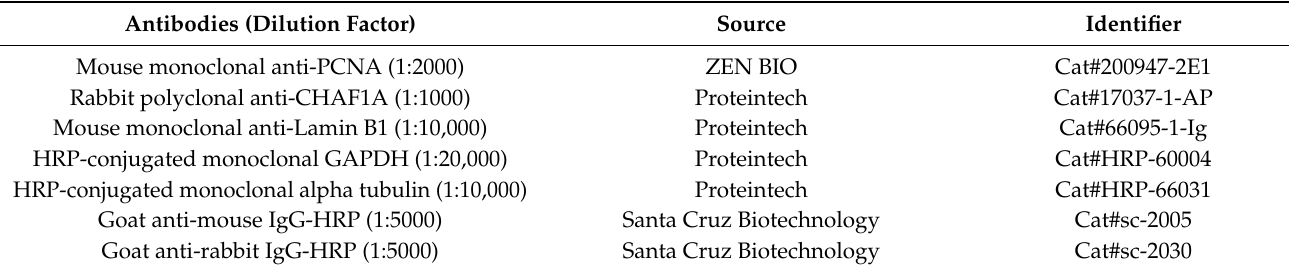
Table 1. Antibodies used in western